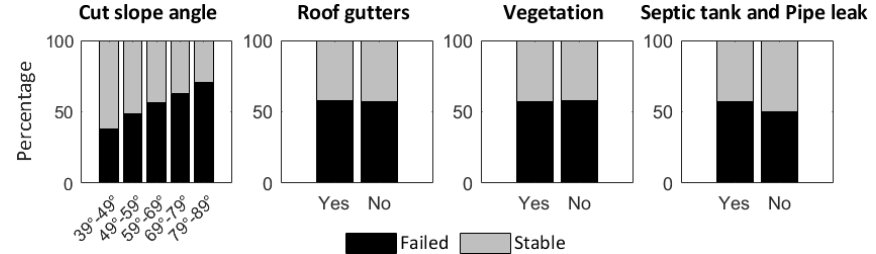
Figure 5. Percentage of predicted stable and failed slopes per urban property. An urban property influences slope stability if the percentage of the predicted failures changes with the variation in that urban property.